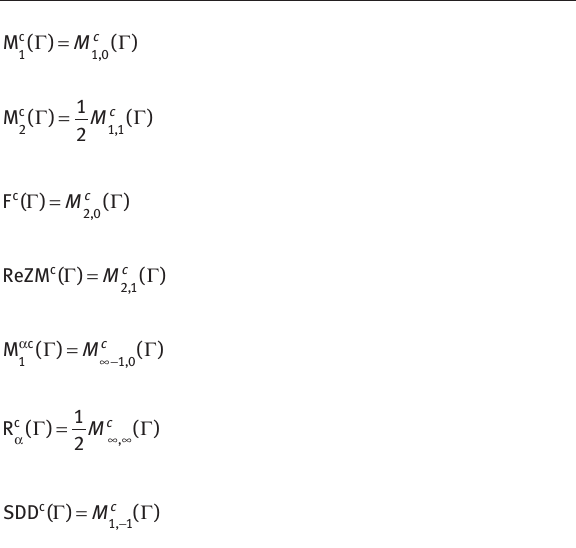
Table 4: Zagreb connection indices in terms of generalized Zagreb connection